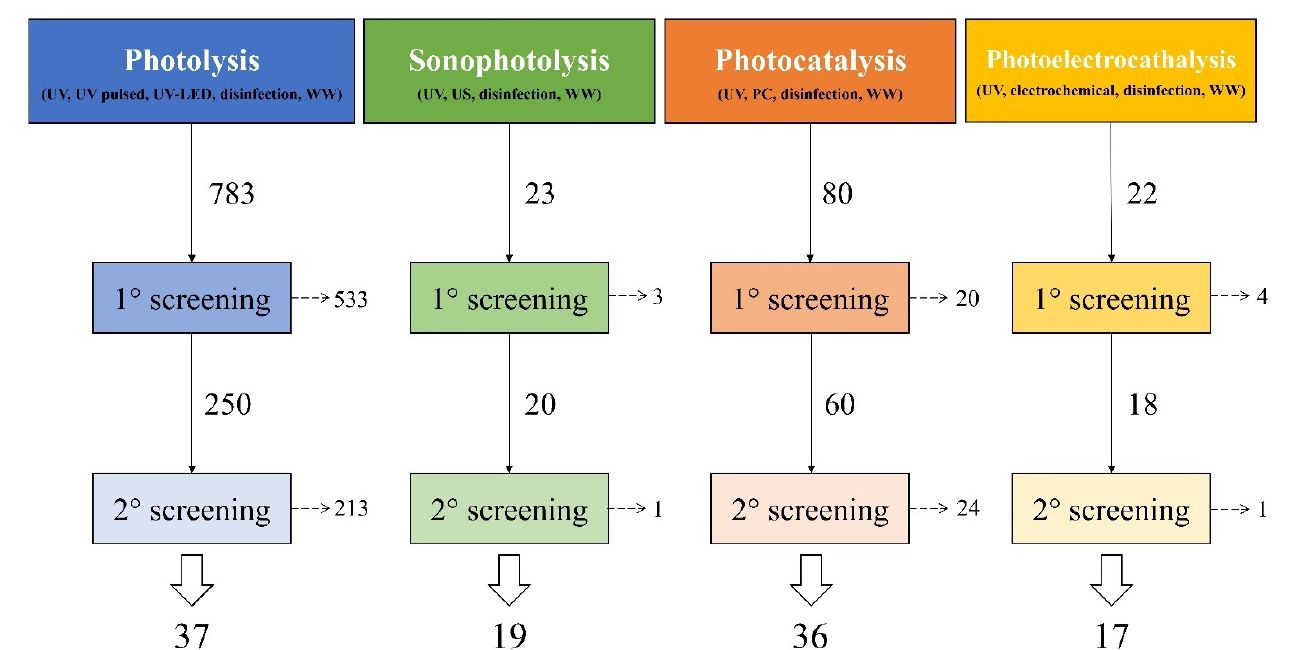
Figure 1. Representation of the multi-step analysis for the screening of literature with the final numbers of reviewed publications. Keywords used in search on Scopus ® database are reported in brackets. UV: ultraviolet radiation, WW: wastewater, US: ultrasound, PC: photocatalysis.